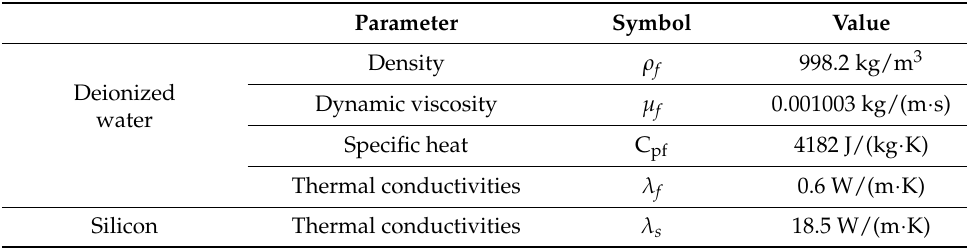
Table 2. Thermophysical properties at room temperature and atmospheric pressure; these properties were used in the